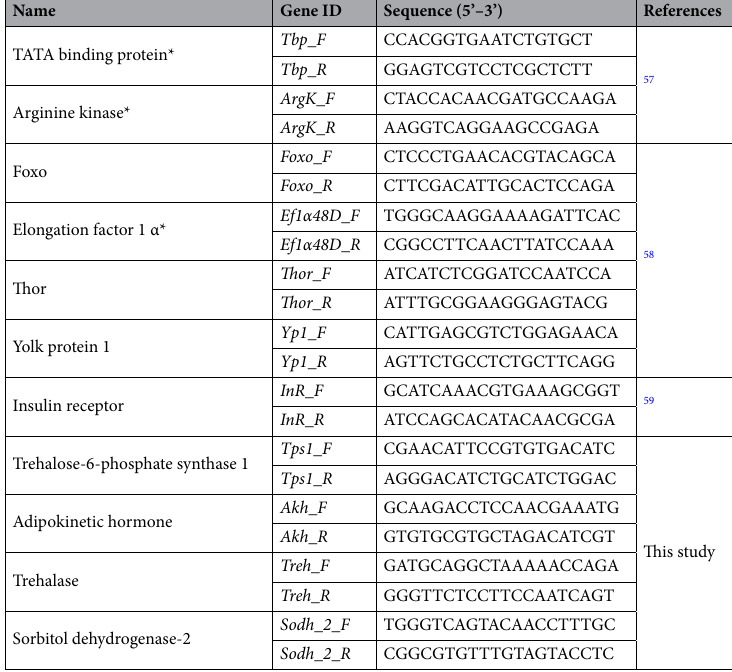
Table 2. Primer sequences used for the RT-qPCR gene expression analysis. *Housekeeping